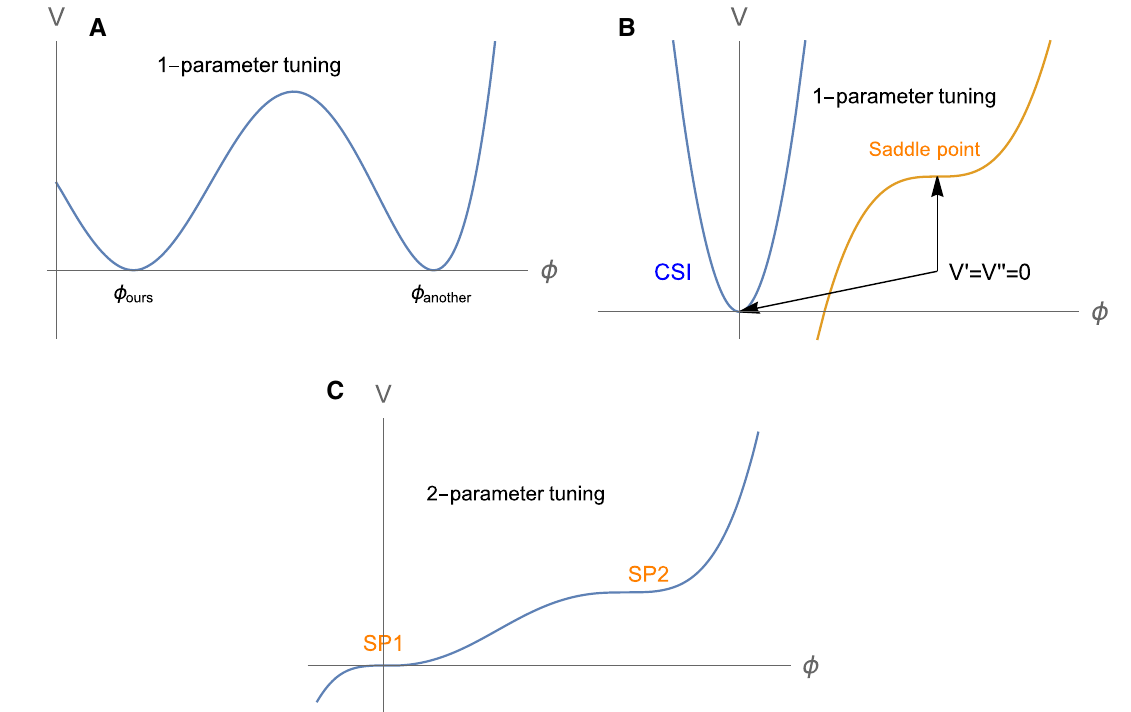
Fig. 1 Typical examples of the effective potential resulting from the